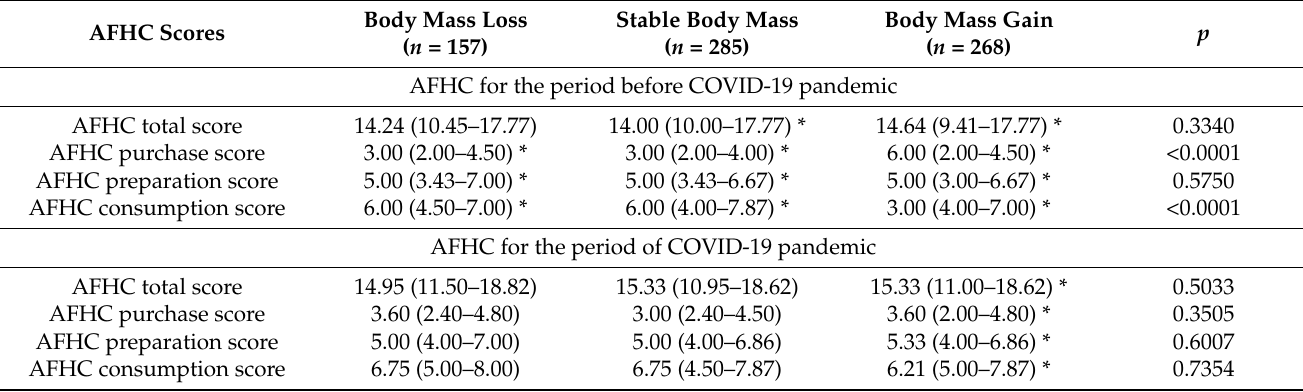
Table 1. The Adolescents’ Food Habits Checklist (AFHC) scores for the period before the COVID-19 pandemic and for the period of COVID-19 pandemic, stratified by body mass changes during the COVID-19 pandemic, for the population of female adolescents from the Diet and Activity of Youth during COVID-19 (DAY-19) Study ( n =